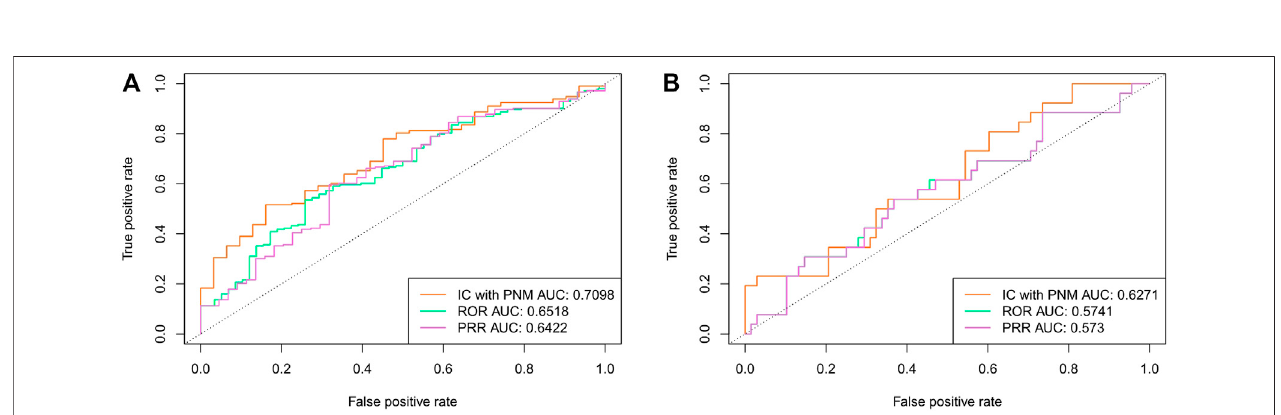
FIGURE 3 | (A) Comparison of performances of IC PNM , ROR, and PRR with SIDER data as the testing set using FAERS 2004 – 2009 data (B) Comparison of performances of IC PNM , ROR, and PRR with OMOP data as the testing set using FAERS 2004 – 2009 data.